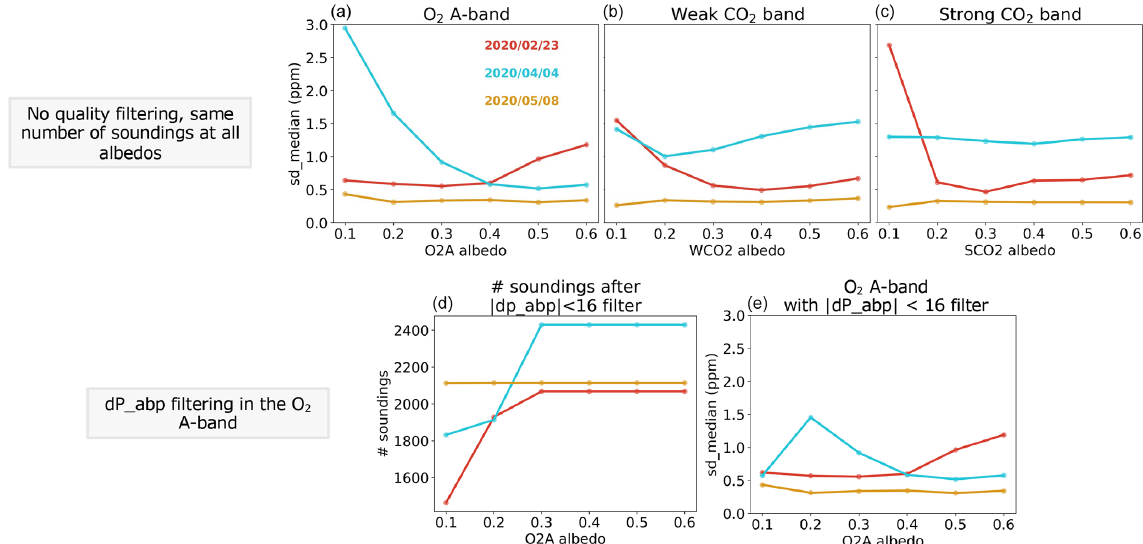
Figure 16. SB strength (sd_median) depending on surface albedo in each of the three OCO-3 bands. Panels (a) – (c) include no quality filtering, and the number of soundings per day is the same for each albedo run. Panels (d) and (e) show how dP_abp filtering affects sd_medians in the O 2 A-band (it has no effect in the other two